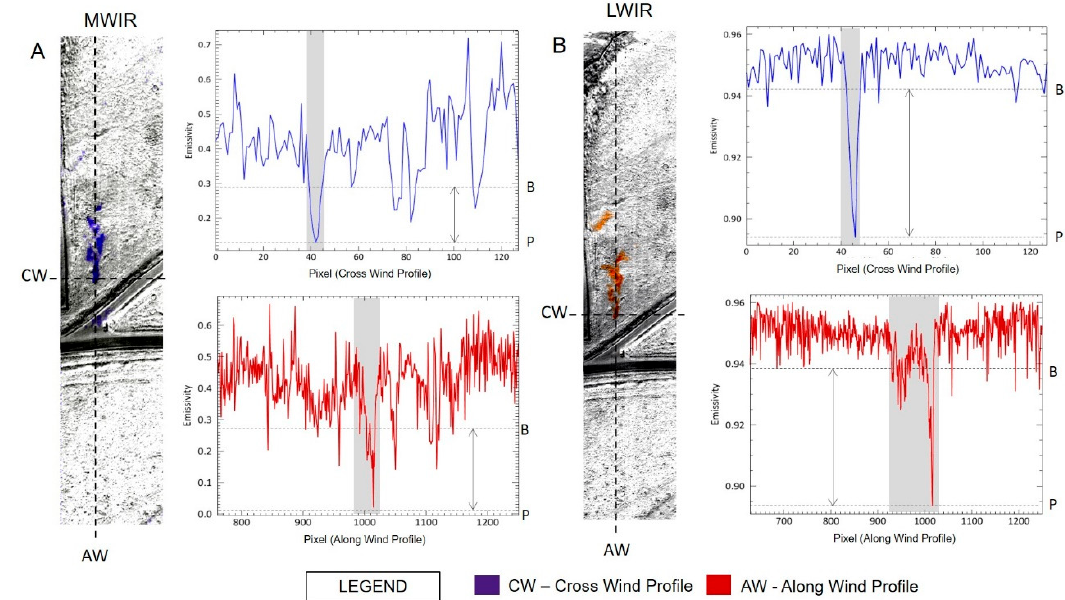
Figure 9. Along-wind (AWP) and cross-wind (CW) profiles of MWIR ( A ) and LWIR ( B ) images acquired over Station 5. Areas in grey outline the CH 4 features centered at 3.3 µm and 7.7 µm in the respective plots. The difference between emissivity values of the pixels of the plume (P) and background (B) is expressive in the LWIR images whereas, for the MWIR, this difference is impaired due to the proximity of the average values between the plume and background.